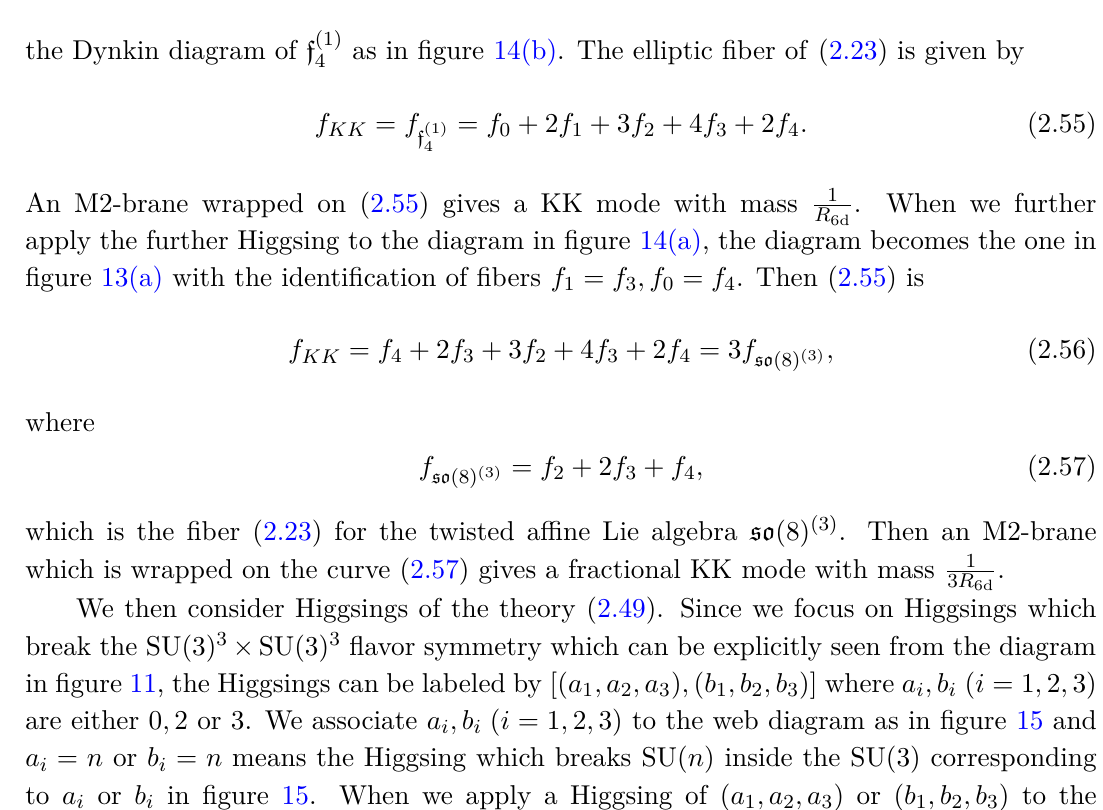
the Dynkin diagram of f (1)